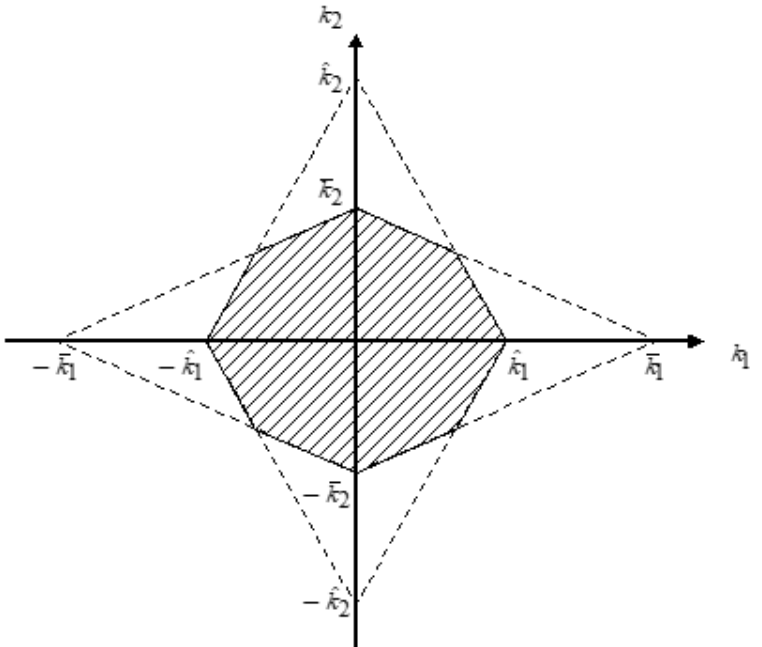
Figure 1. The admissible region k 1 and k 2 for the controller (2).